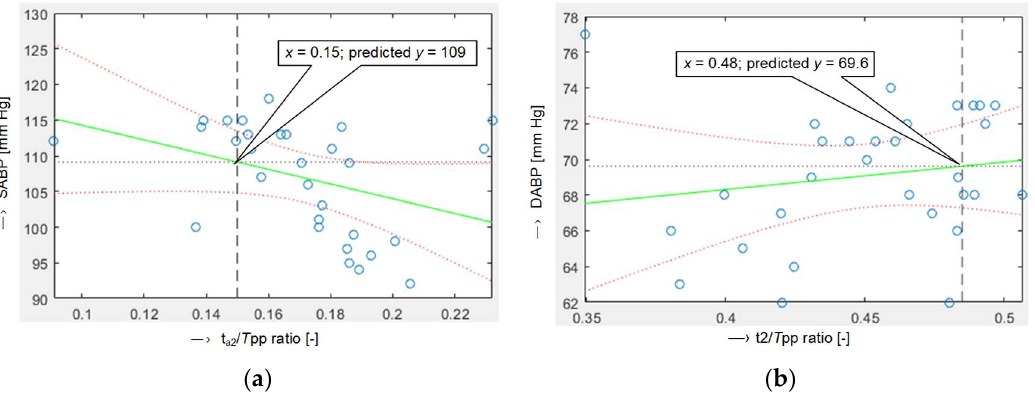
Figure 3. Examples of calculated conversion linear characteristics using: ( a ) ta2/ T pp ratio for estimation of SABP values, ( b ) t2/ T pp ratio for DABP estimation.